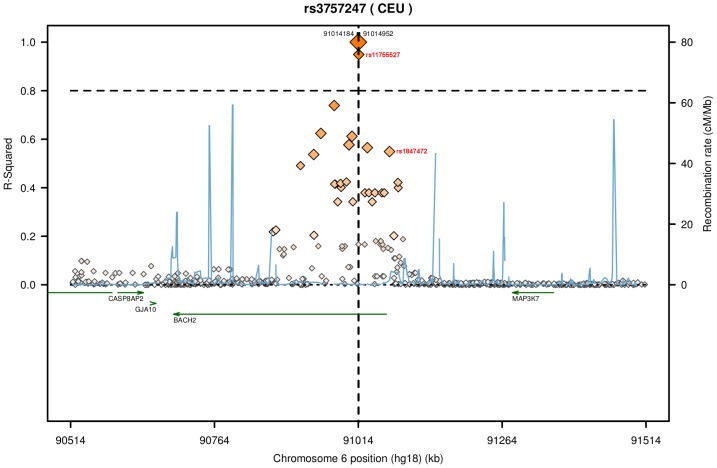
Regional LD plot for SNP rs3757247 associated with IBD and T1D loci.The regional LD plot for SNP rs3757247 was calculated using HapMap3 (release 2) in SNAP tool. SNPs are represented as diamonds and the brightness of each SNP is proportional to the r2 threshold value for that SNP. SNPs rs11755527 and rs1847472 had an r2 value of 0.949 (T1D p-valuemeta 5.38e-08, Barrett et al 2009 [52]) and 0.565 (IBD p-valueichip 1.19e-04, IBD p-valuemeta 1.10e-09, Jostins et al 2012 [71]) respectively (shown in red).